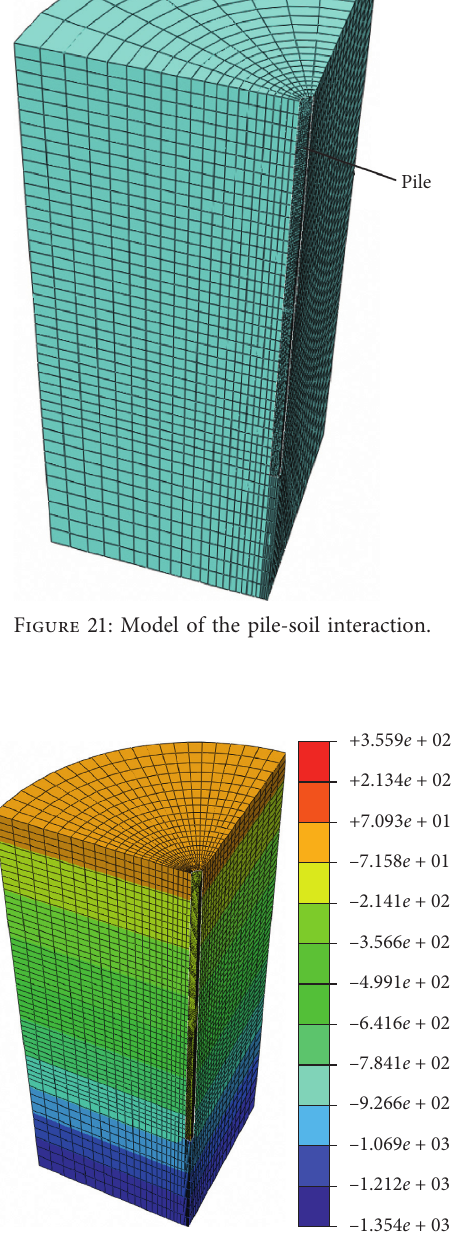
Figure 22: Stress contours of pile-soil interaction.